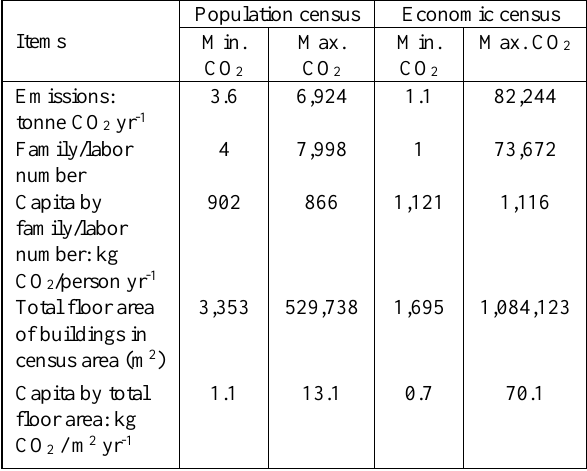
Table 1. Extraction of building emissions estimated by census